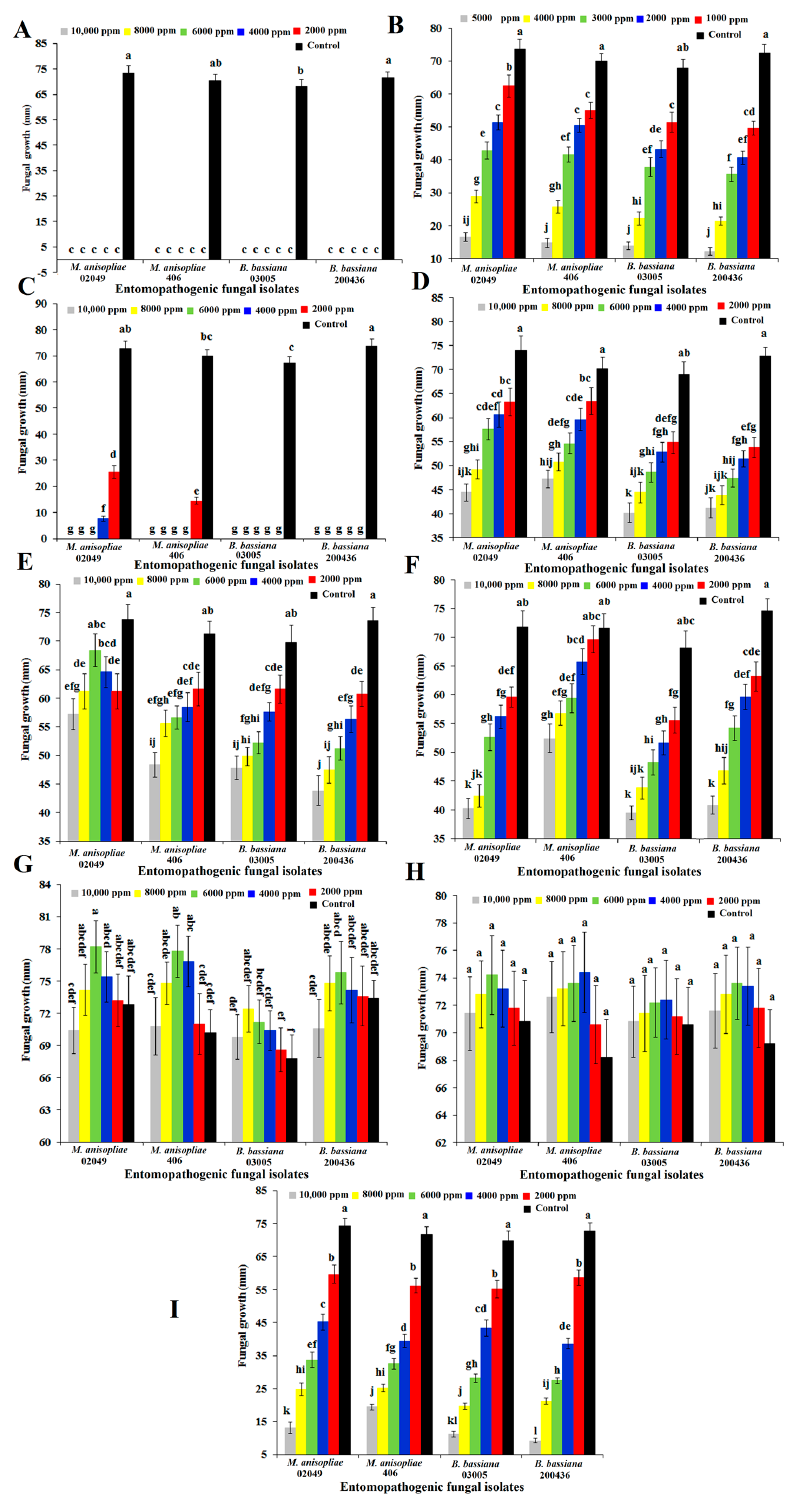
Figure 1. The effect of different concentrations of n -hexanoic acid ( A ), naphthalene ( B ), nonanal ( C ), n -pentadecane ( D ), n -tetradecane ( E ), n -heptadecane ( F ), n -hexadecane ( G ), oleic acid ( H ) and methyl octanoate ( I ) on the radial growth (12-d colony diameter) of entomopathogenic fungal isolates at 26 ± 1 ◦ C, in complete darkness. Mean ± SE values followed by different letter(s) are significantly different (Fisher’s LSD test, α = 0.05). Values are the means of five replicates, and each replicate is the average of five Petri